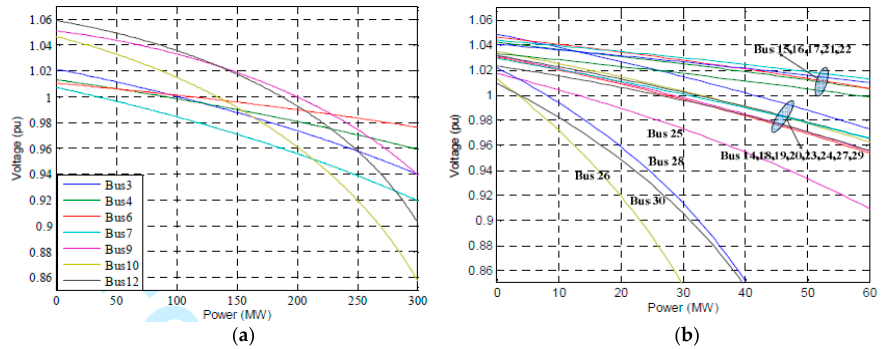
Figure 6. ( a ) Power–voltage ( P ‐ V ) curves for generation areas of the IEEE 30 bus system; ( b ) P ‐ V curve for loading areas of the Institute of Electrical and Electronic Engineers (IEEE) 30 bus system.